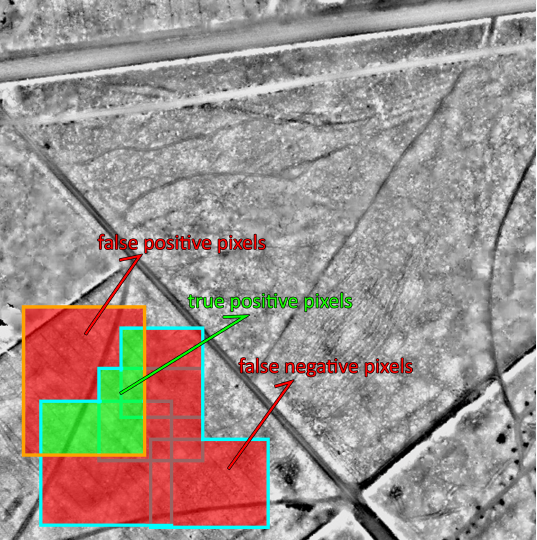
Figure 7. The pixel-based measure provides a quantitative evaluation of the coverage of the ground truth bounding boxes with the predicted ones. The figure shows that a polygon representing an archaeological landscape pattern (a Celtic field) is annotated using a series of overlapped bounding boxes (ground truth (cid:110) ). Each pixel of a predicted ( (cid:110) ) bounding box is considered as a TP ( (cid:110) ) if it belongs to one of the ground truth bounding boxes; otherwise, it is considered as FP ( (cid:110) ). The pixels of each ground truth bounding boxes that are not covered by any predicted bounding box are considered as FN ( (cid:110) ) (see Section